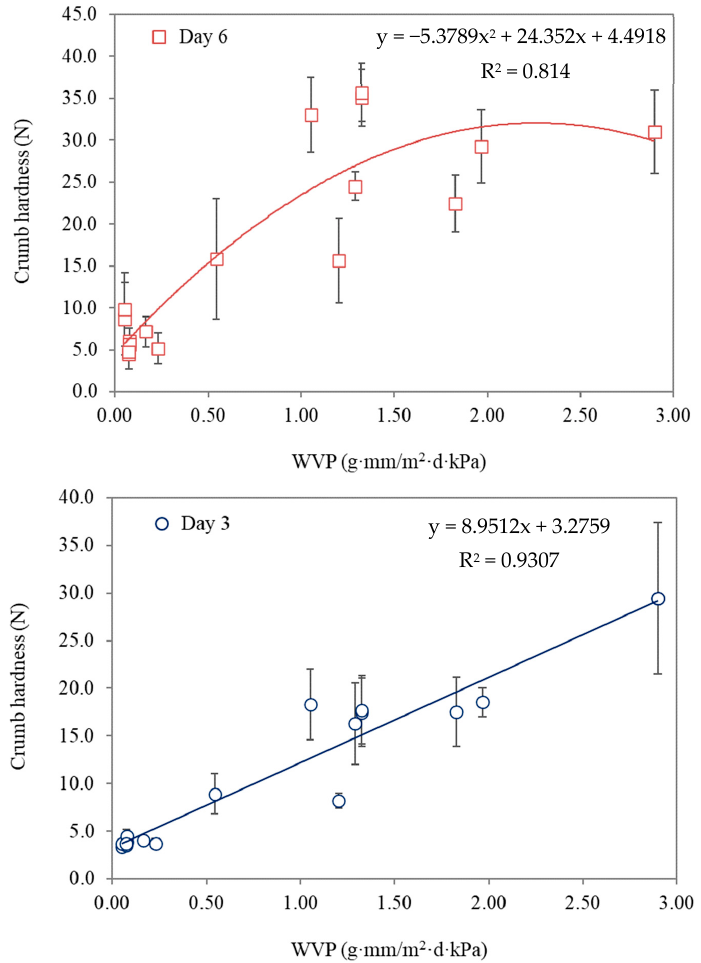
Figure 2. The relationship between water vapor permeability and crumb hardness at 3 and 6 days of storage at room temperature (reproduced with permission from Bumbudsanpharoke et al. (2022) [26]).